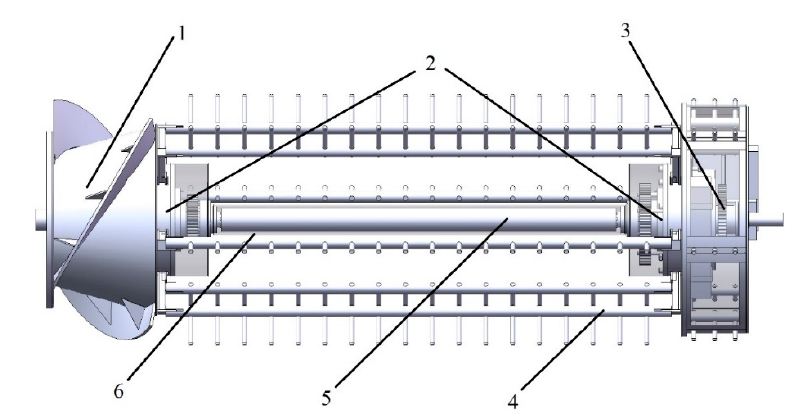
Figure 2. 3D diagram of variable-diameter threshing drum, 1. Feed wheel, 2. Diameter adjustment device, 3. Electronic control self-locking device, 4. Threshing rack, 5. Drum main shaft, 6. Sleeve.